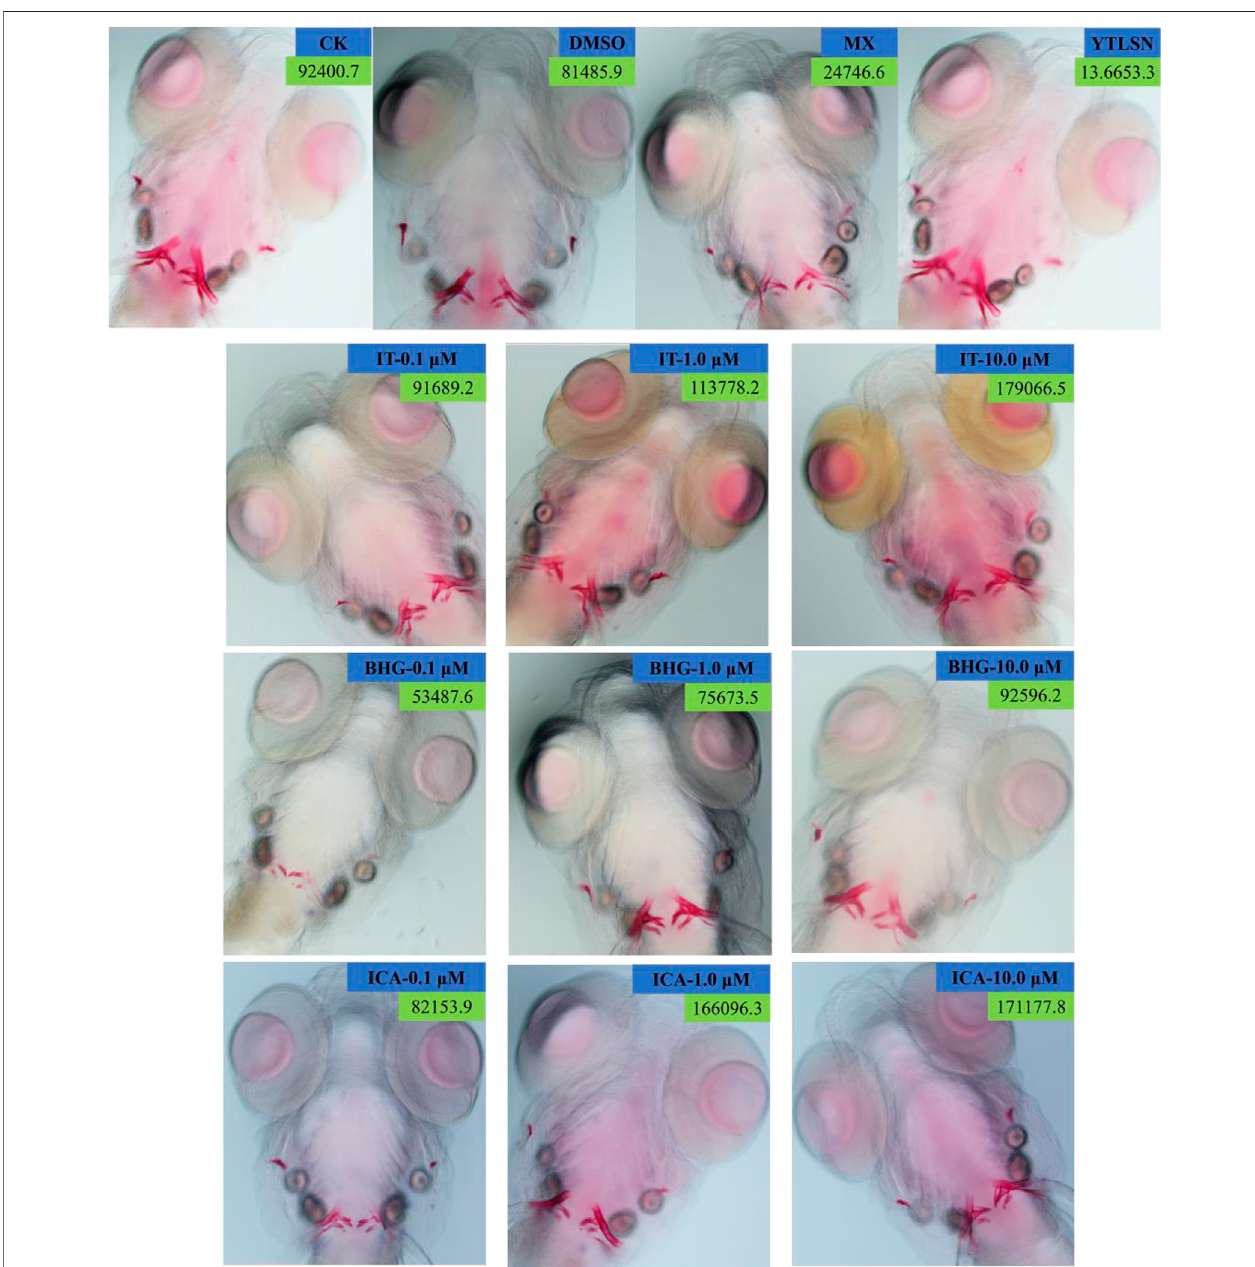
FIGURE 3 | Ventral view of Alizarin Red stained zebra fi sh skull at 10 DAF (×100). CK, blank E 3 medium; DMSO, 0.5% DMSO; MX, 25 μ M PNSL; YTLSN, 15 μ M disodium ethydronate + 25 μ M PNSL; ICA, 0.1, 1.0, or 10.0 μ M ICA + 25 μ M PNSL; BHG-I, 0.1, 1.0, or 10.0 μ M BHG-I + 25 μ M PNSL; IT, 0.1, 1.0, or 10.0 μ M IT + 25 μ M